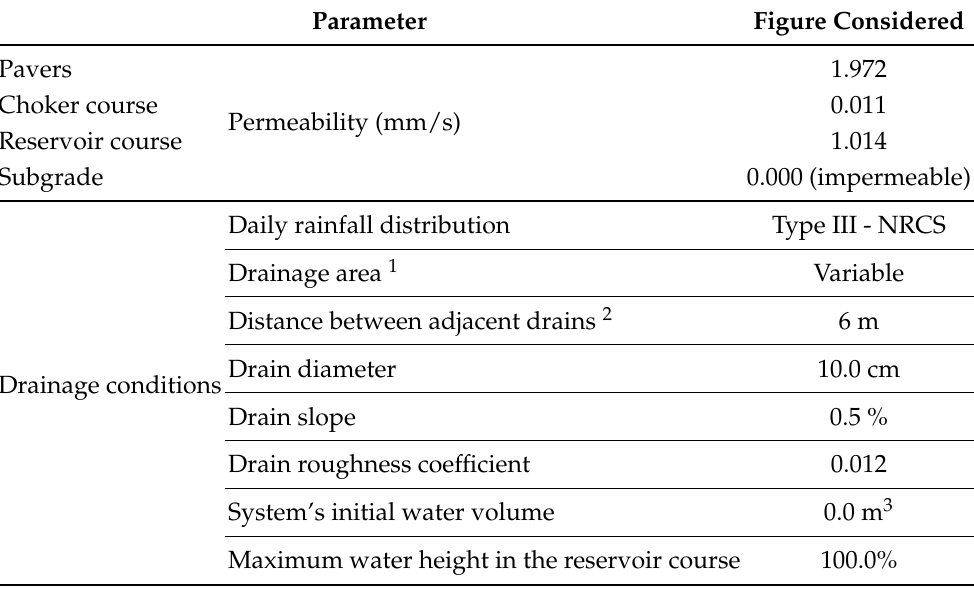
Table 9. Hydrologic/hydraulic design parameters.